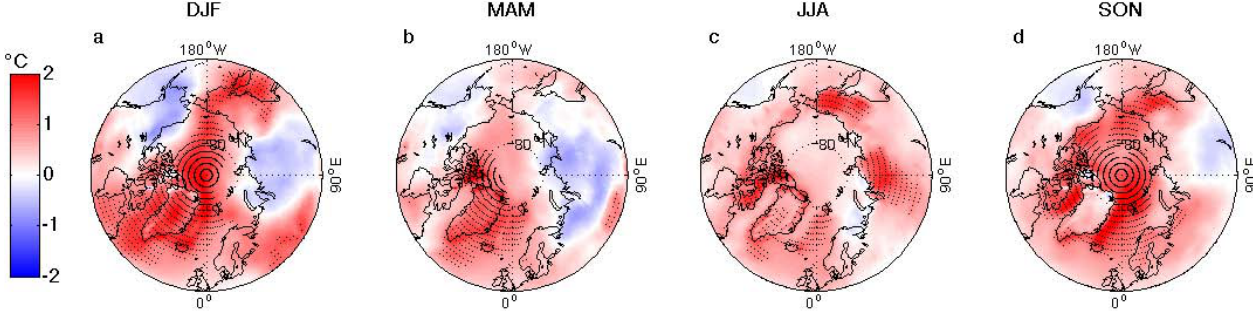
Fig. 11. Two-meter air temperature difference ( 1T ), in ◦ C, due to light-absorbing particles in snow and sea ice for each season. Hashes indicate where differences are significant in this and other figures where they appear.